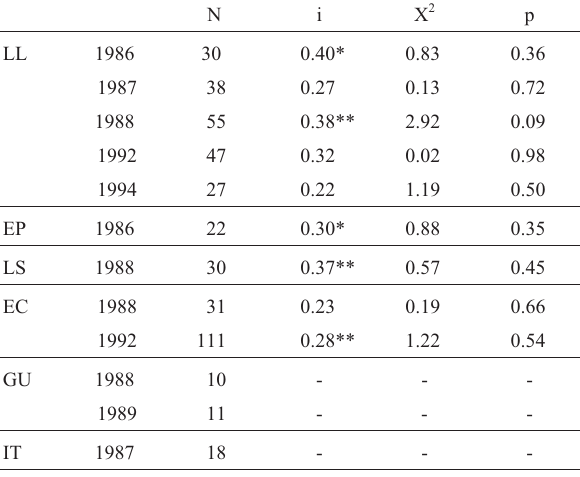
Table 1 - Inversion M4 frequencies (i) in six Sinipta dalmani populations from Entre Ríos and Buenos Aires provinces showing the number of ana- lysed males (N) and X 2 values of fit and goodness test. LL: Los Loros, EP: El Palmar, LS: Los Sauces, EC: El Camino, GU: Gualeguaychú.